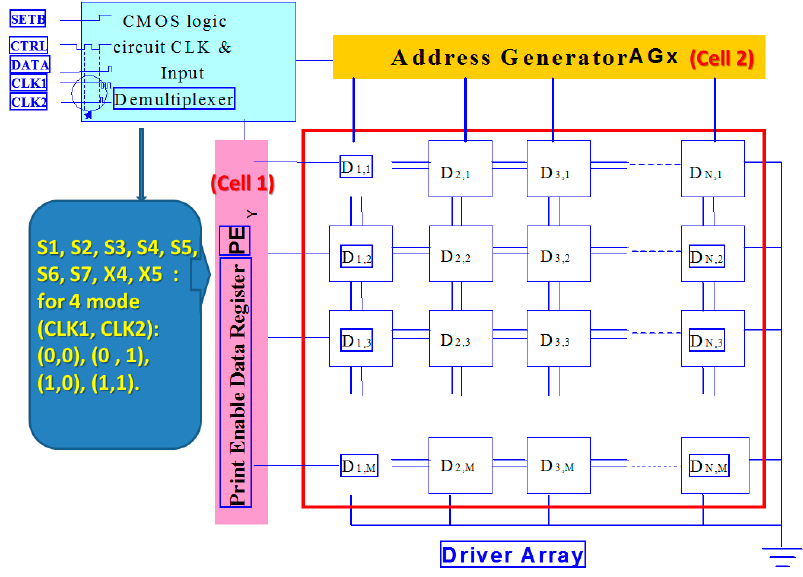
Figure 1. Multiplexer ink jet head of the uppermost layer within the inkjet driver wafer.